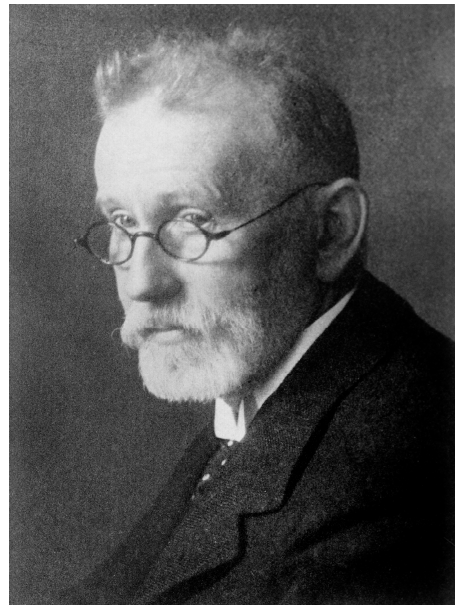
Figure 5. Paul Ehrlich.